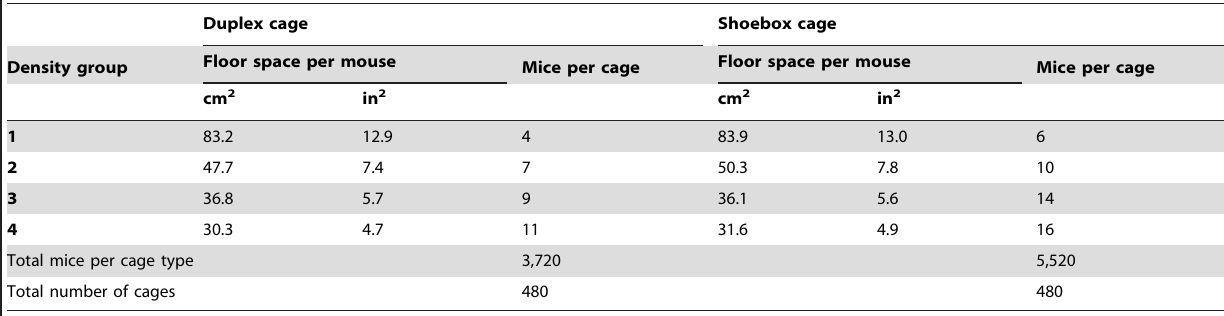
Table 1. Density and floor space according to cage type a .